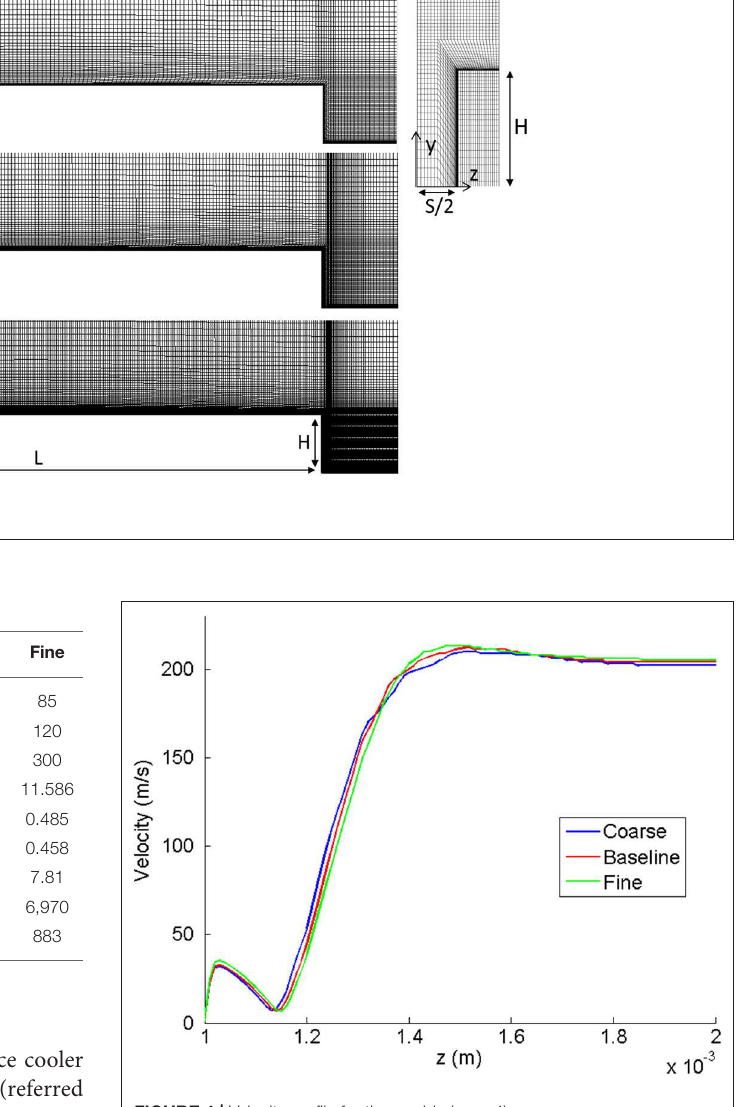
FIGURE 4 | Velocity profile for three grids (case